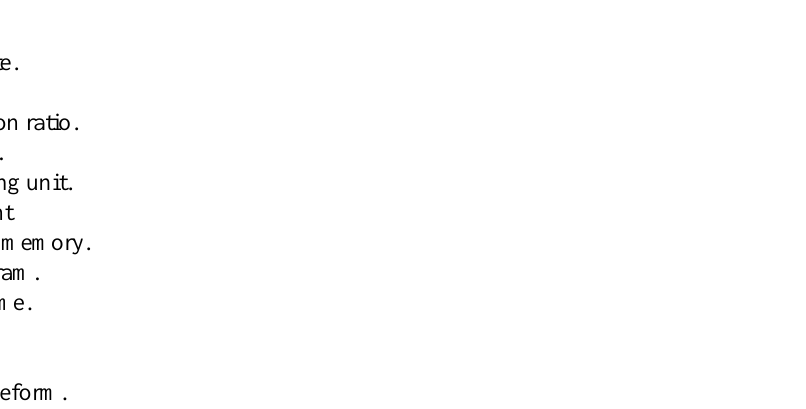
Chang A, Culurciello E. Hardware accelerators for recurrent neural networks on FPGA. 2017 Presented at: IEEE International symposium on circuits and systems (ISCAS); 2017; Baltimore, USA p. 1-4. [doi: 10.1109/iscas.2017.8050816]